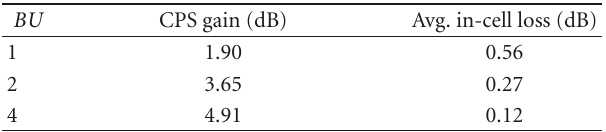
Table 1: Gain and loss of